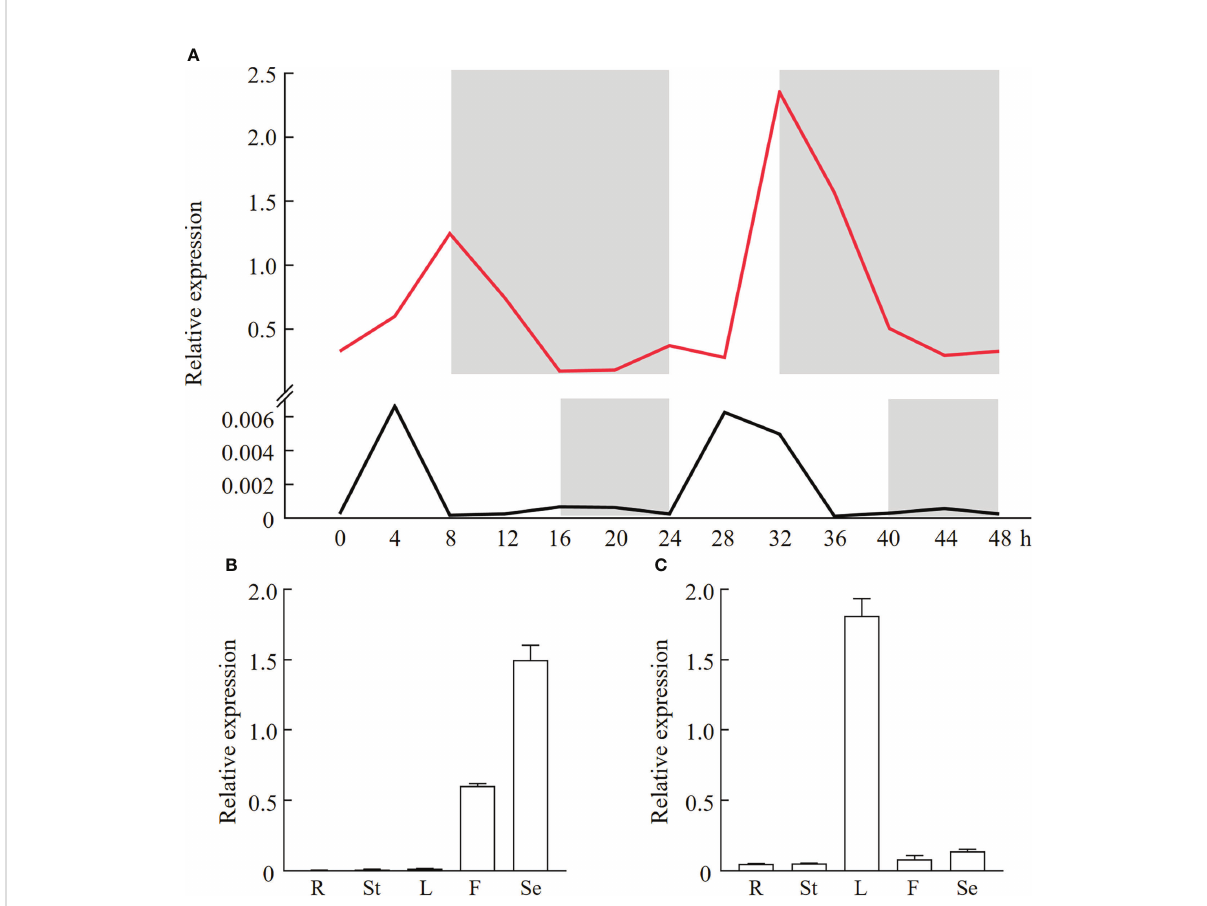
FIGURE 6 Diurnal expression pattern and tissue speci fi city analysis of PfFT1 in P. frutescens . (A) Diurnal expression pattern of PfFT1 in leaves under the SD (red line) or LD (black line) photoperiod. The dark duration was shaded with gray. Relative expression level of PfFT1 in different tissues under the SD (B) or LD (C) photoperiod. R, roots; St, stems; L, leaves; F, fl owers; Se, seeds. The roots, stems, leaves, fl owers at fl owering stage (56/141 DAS) were collected, and mature seeds were collected at 86/171 DAS under SD and LD condition,